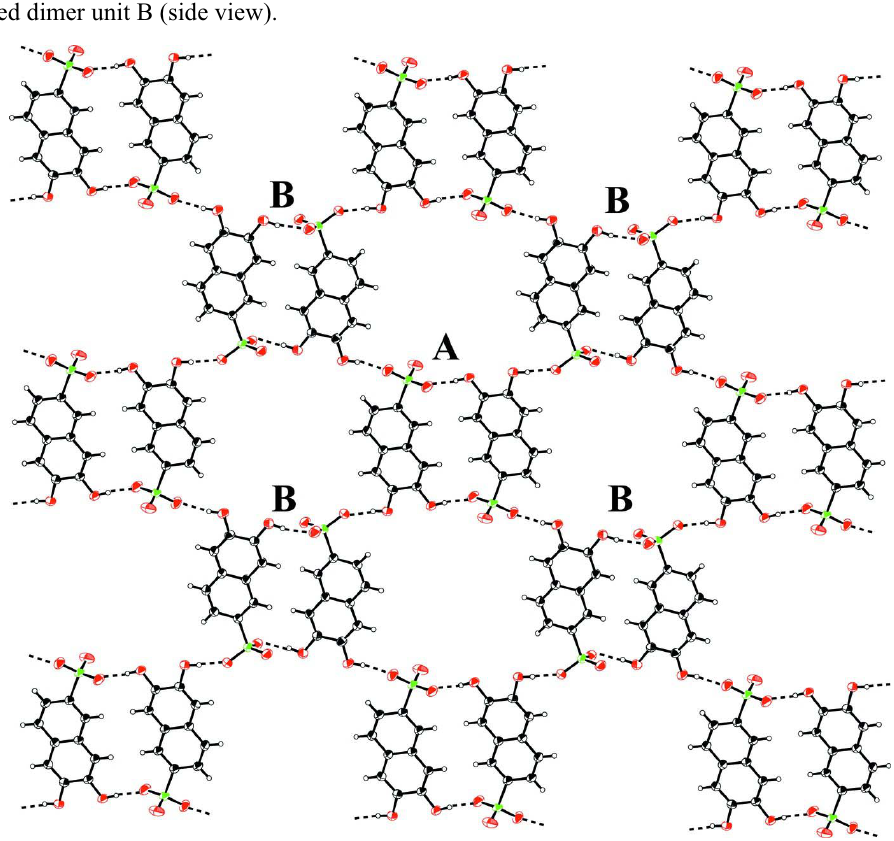
Figure 6 Two-dimensional hydrogen-bond network. Unit A is hydrogen-bonded to four units B and vice versa